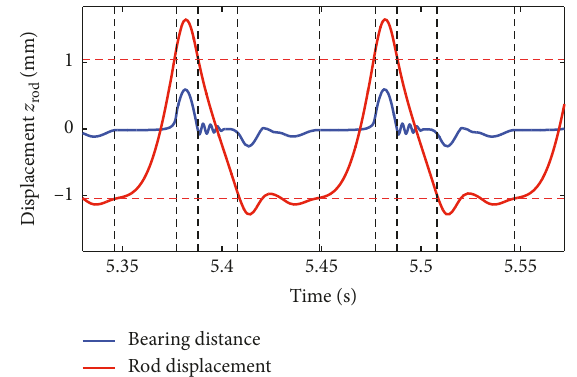
Figure 19: Displacement z c r �